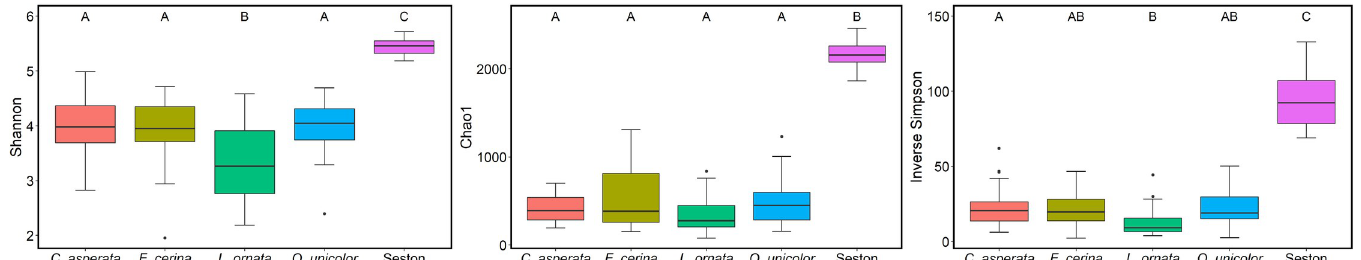
Fig 4. Shannon evenness, Chao1 richness, and Inverse Simpson diversity of the gut microbiota of four freshwater mussel species (in order shown: Cyclonaias aspertata , Fusconaia cerina , Lampsilis ornata , and Obovaria unicolor) at six sites in the Sipsey River, AL, USA, and for seston collected from the same sites, as determined from Illumina 16S rRNA gene sequencing. Seston bacterial evenness, richness, and diversity were higher than those metrics observed in the mussel gut (p < 0.001). L . ornata the lowest evenness and diversity scores of the four mussel species. Error bars represent standard error of the 22–29 samples of each mussel species collected, or the 18 seston samples collected across all sites.